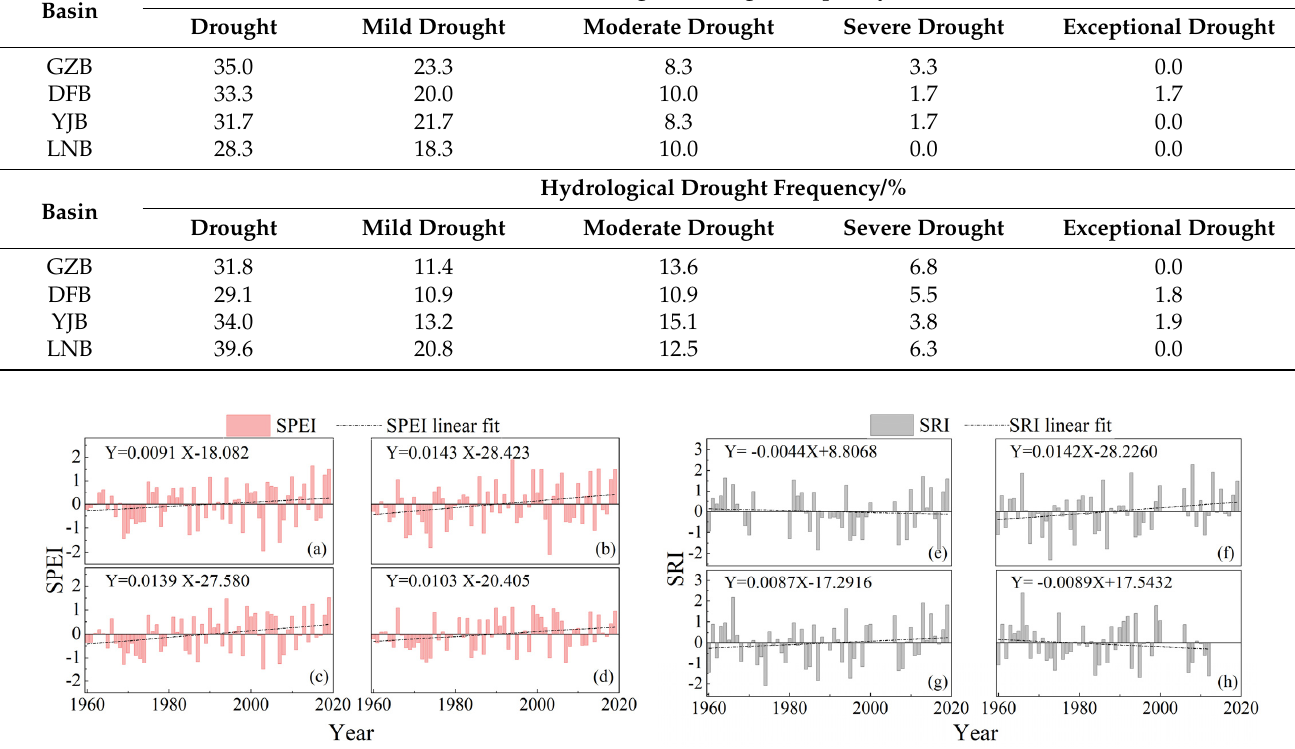
Figure 2. Interannual variation of the SPEI ( a – d ) and SRI ( e – h ) in the YLB from 1960 to 2019, including GZB ( a , e ), DFB ( b , f ), YJB ( c , g ), and LNB ( d , h ).